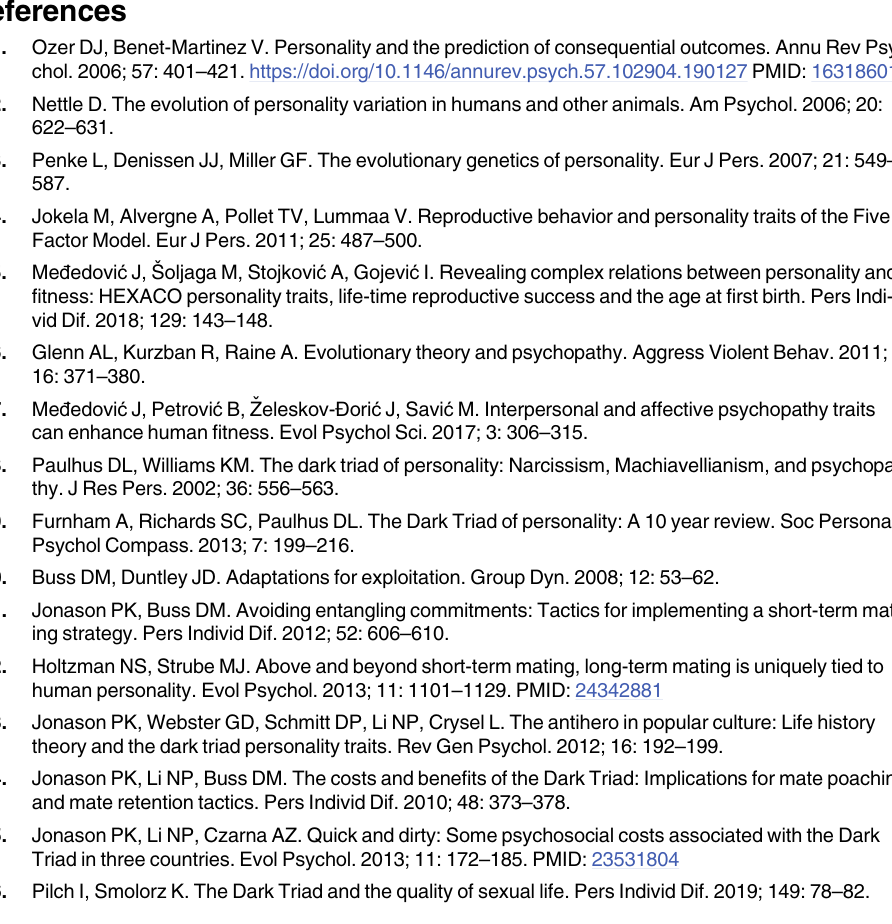
S2 Table. Multilevel estimates predicting momentary affect from Machiavellianism,